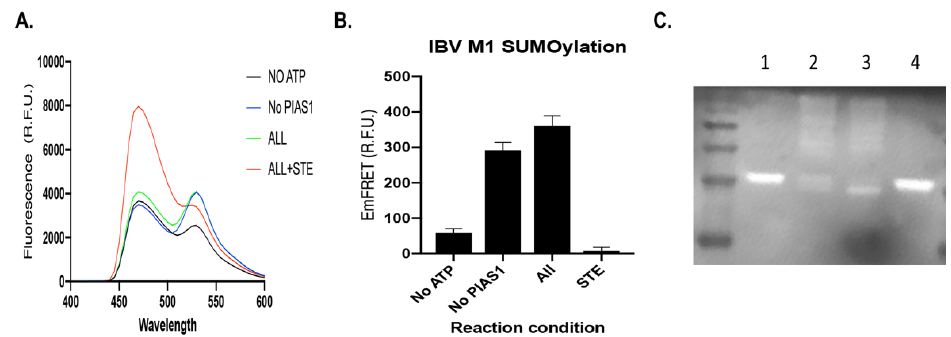
Figure 3. The M1 protein of IBV was SUMOylated and the SUMOylation of the M1 protein was inhibited with the SUMOylation inhibitor STE025 in both vitro FRET assay and the biochemical assay. ( A ) The FRET spectrum of the in vitro SUMOylation reaction of IBV M1 protein using the FRET assay. Four reactions were conducted, CyPet-SUMO1, E1, E2, E3, YPet-M1, and ATP (ALL and green); CyPet-SUMO1, E1, E2, YPet-M1, and ATP (no PIAS1 and Blue); E1, E2, E3, YPet-M1 and no ATP (NO ATP and black); CyPet-SUMO1, E1, E2, E3, YPet-M1, ATP, and STE (ALL plus STE and red). ( B ) Quantitative FRET signal (EmFRET) of IBV M1 SUMOylation from ( A ). ( C ) In vitro